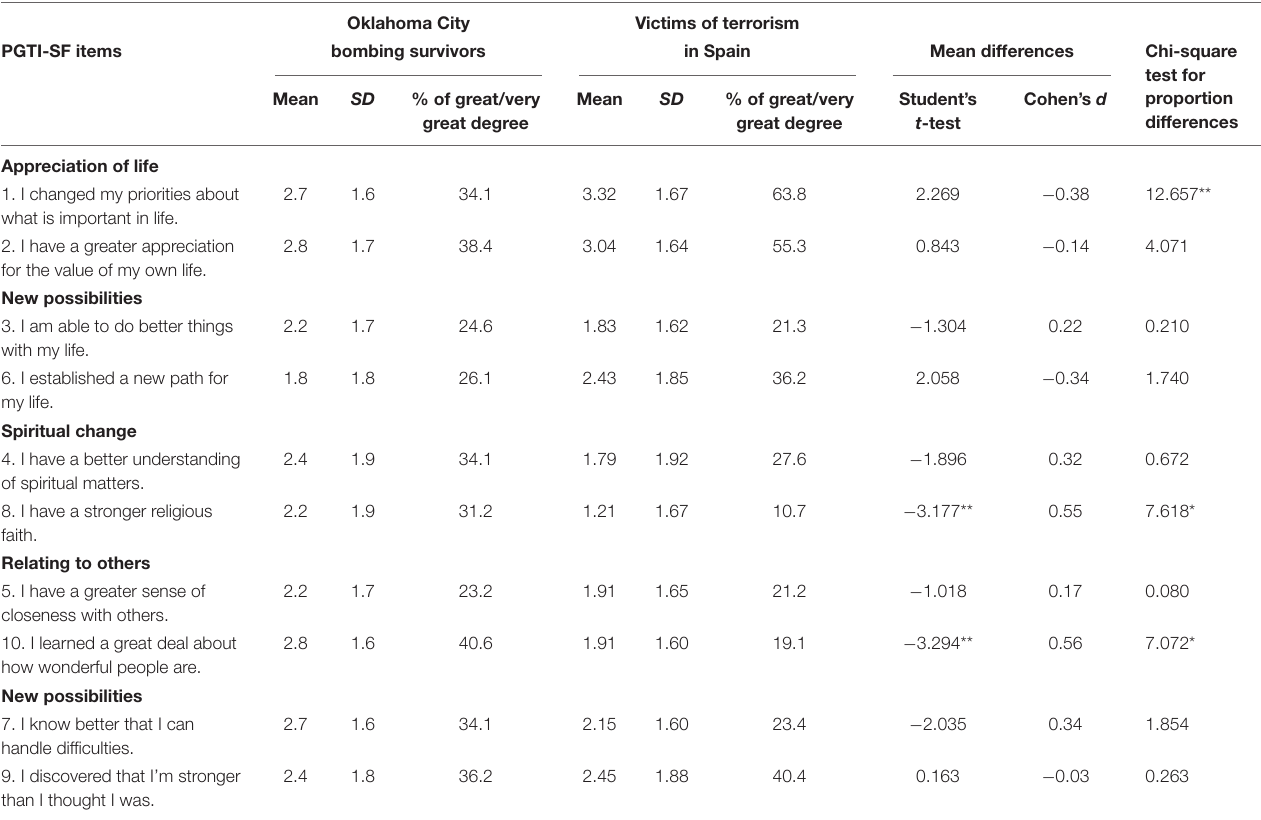
TABLE 2 | Mean scores and percentages of “great/very great degree” responses in the PTGI-SF items: Oklahoma City bombing survivors ( N = 138; Tucker et al., 2016) vs. victims of terrorism in Spain who suffered a terrorist attack 10–25 years ago ( n = 47). Oklahoma